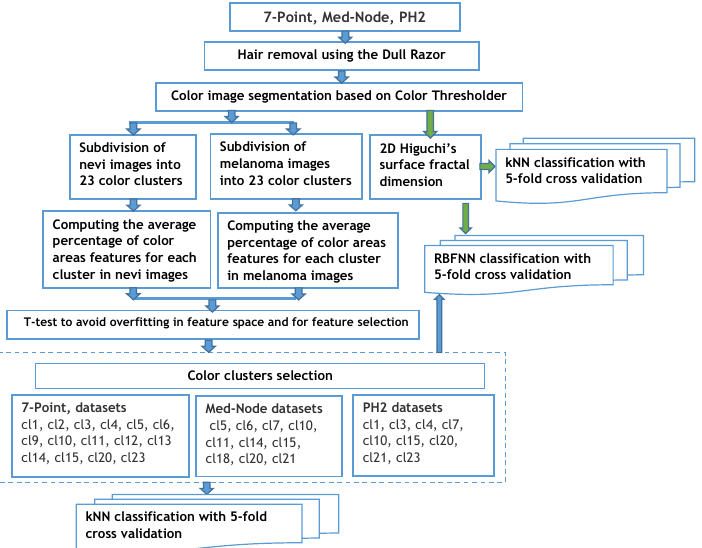
Figure 1. Processing steps for classifying skin lesions.